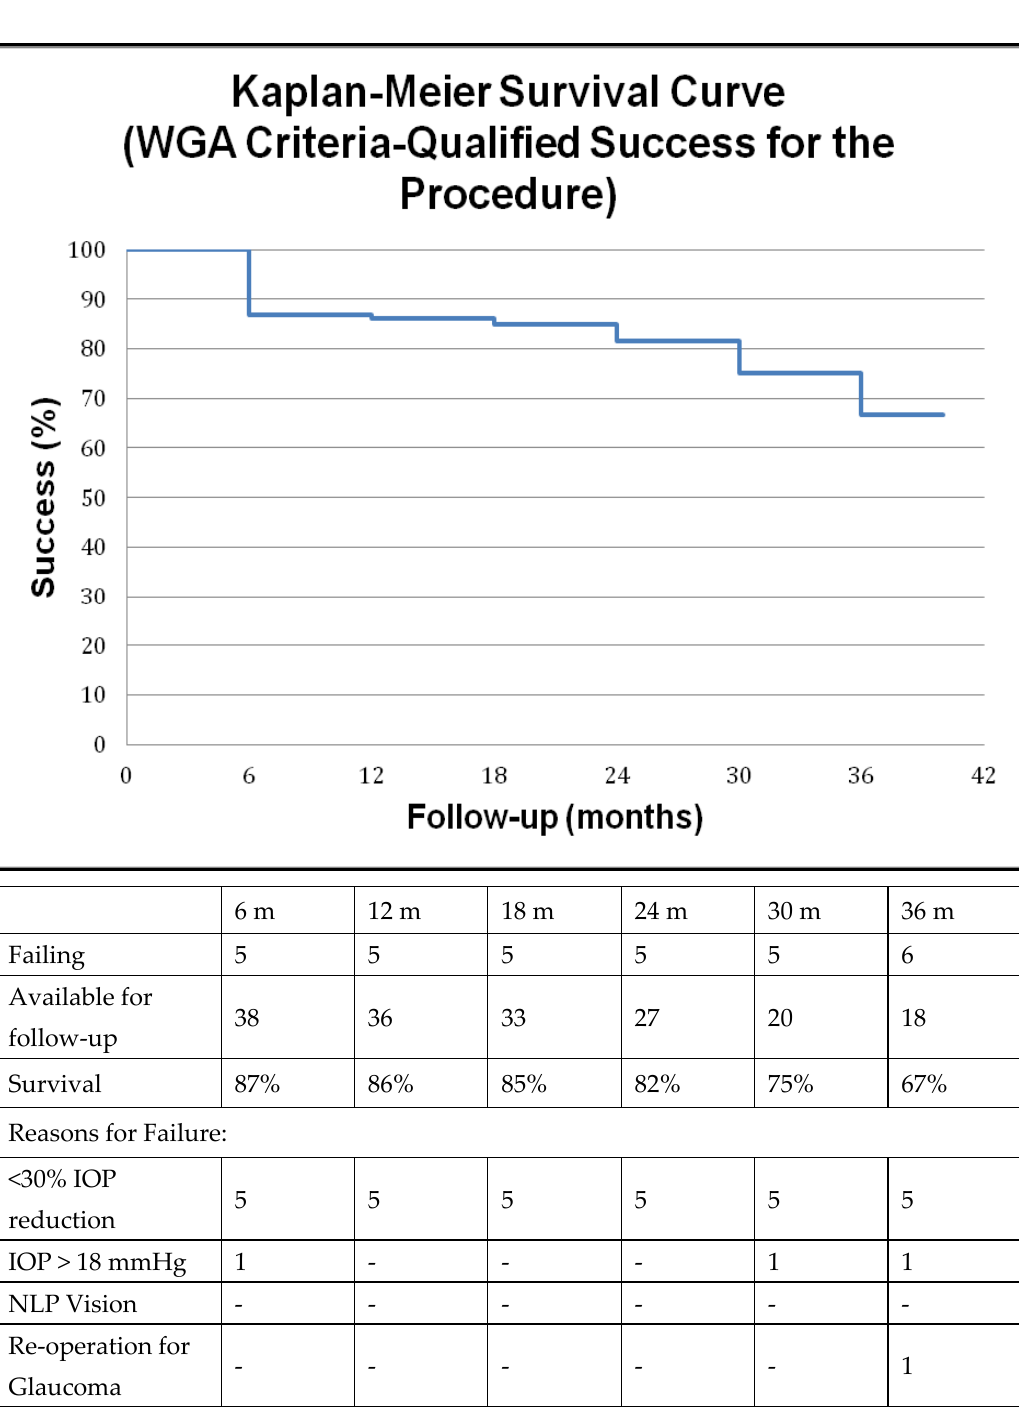
Figure 4. Kaplan–Meier survival curve with or without medications for the surgical procedure according to the World Glaucoma Association (briefly failure was defined as intraocular pressure (IOP) > 18 mmHg, or IOP not reduced by at least 30% or re-operation for glaucoma or loss of light perception.